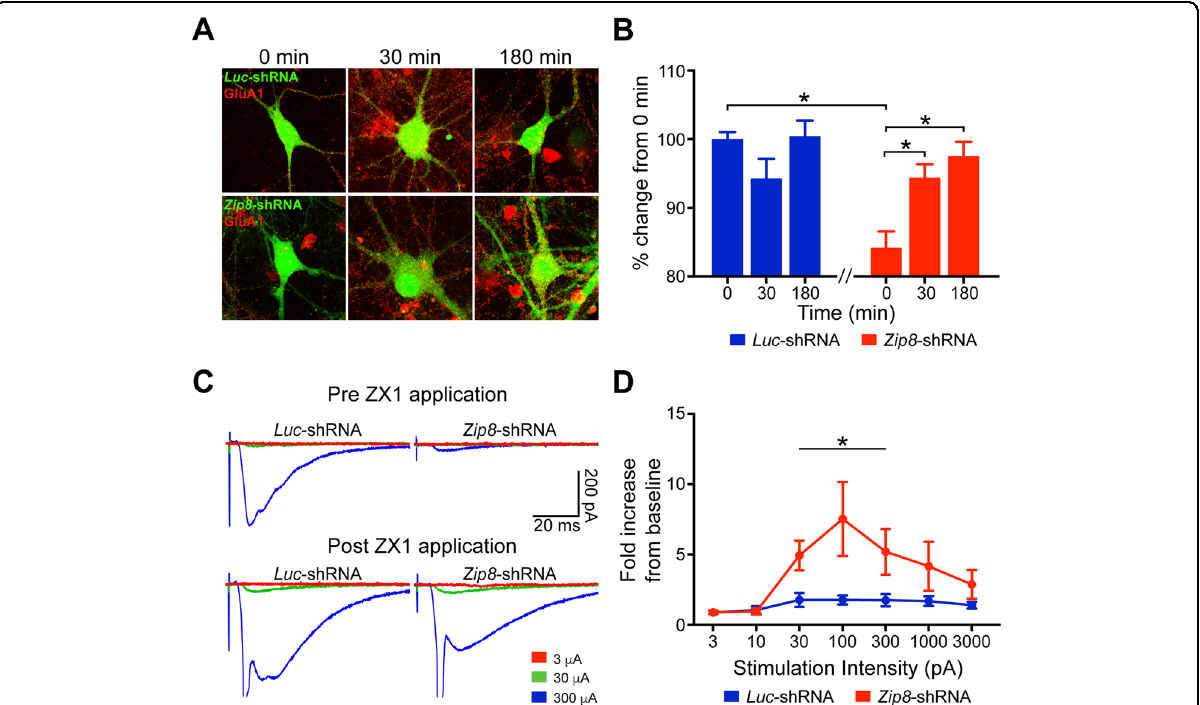
Fig. 4 Zinc chelation rescues GluA1 receptor surface localization and evoked EPSC amplitude in hippocampal CA1 neurons. A Time course of 100 μ M ZX1 treatment in Luc - or Zip8 -shRNA-expressing cultured pyramidal neurons stained with antibodies against the GluA1 subunit. B Quanti fi cation of GluA1 puncta over time following ZX1 application. Data are normalized to Luc -shRNA at 0 min. Note the signi fi cant difference between treatments prior to zinc chelation (two-way ANOVA followed by Sidak ’ s post hoc test; Luc vs. Zip8 at 0 min ( P < 0.001), Zip8 0 min vs. 30 min ( P < 0.02), Zip8 0 min vs. 180 min ( P < 0.04); n = 6 – 10 per group). Error bar, SEM. C Representative traces of Schaffer collateral-evoked EPSCs from hippocampal CA1 neurons transfected in vivo with virus encoding either Luc - or Zip8 -shRNA then recorded ex vivo using whole-cell patch clamp. Recordings made from Schaffer collateral stimulation before and after treatment of ZX1 ( n = 6 per group). Note that the same stimulation intensities given prior to ZX1 now result in a large population event, typical of a loss of zinc-mediated inhibition 33,34 . D Quanti fi cation of evoked signals at different stimulation intensities shown to the right (two-way ANOVA followed by Sidak ’ s post hoc test; Luc + ZX1 vs. Zip8 + ZX1 effect of treatment ( P < 0.0001)). Error bars,